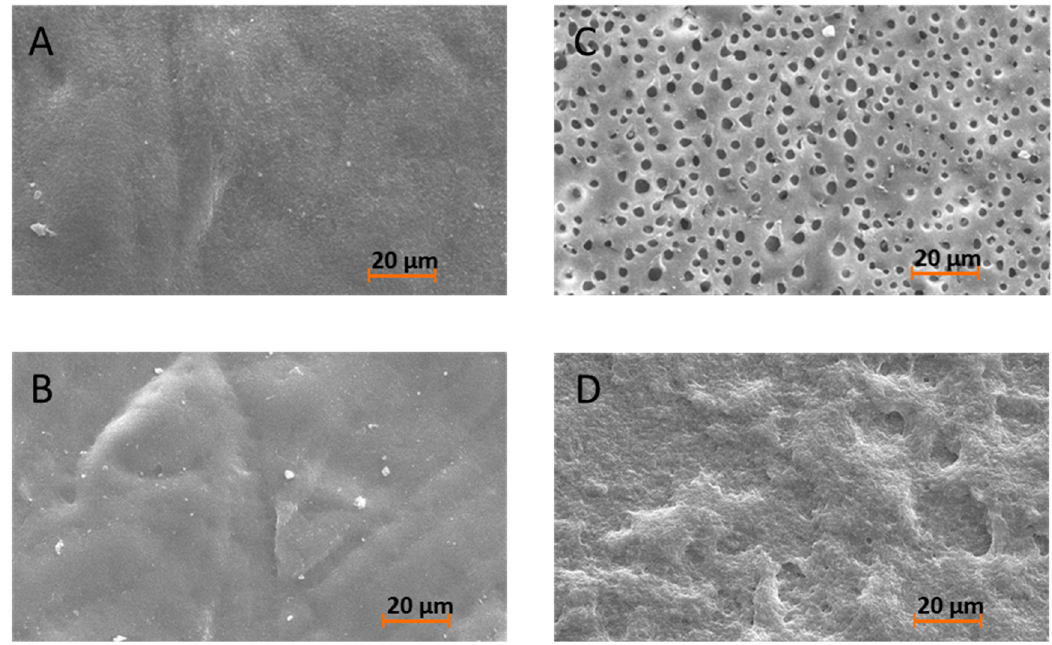
Figure 8. SEM images of the film surfaces of the blends of PLLA and PDLA-b-PCL block copolymers: ( A ): PDLA_3500_PCL_2200, ( B ): PDLA_5000_PCL_830 and blends of PLLA and PCL oligomers ( C ): PCL_2200, ( D ): PCL_830 after toluene treatment.